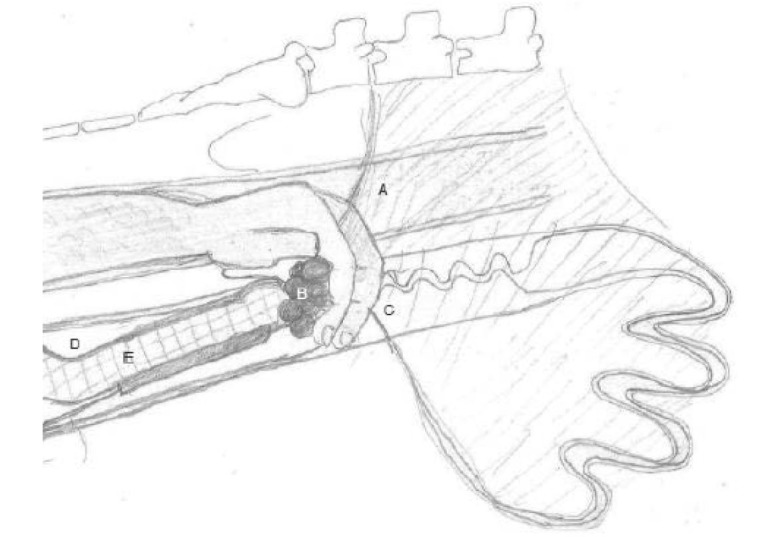
Illustration of the positioning of the transvaginal ultrasound-guided biopsy device. One hand is placed in the rectum (a) and the suspensory ligament of the ovary is palpated. After pulling on the ligament, the ovary is located and the proper ligament of the ovary held between the index and middle fingers, with the ovary on the palm side of the hand. The ovary (b) is pulled along the uterine cervix (c) into the peritoneal part of the pelvic cavity towards the cranial part of the vagina (d). With the other hand, the probe (e) is inserted into the vagina adjacent to the caudal part of the uterine cervix until the ovary becomes visible on the ultrasound screen (Björkman et al., 2017b).